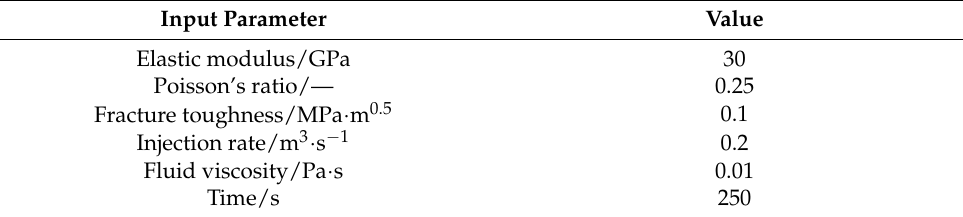
Table 1. Parameter values.